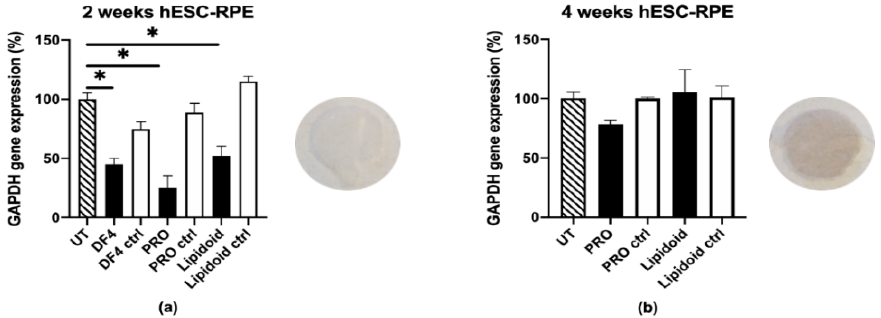
Figure 6. GAPDH mRNA knockdown in ( a ) 2-week and ( b ) 4-week matured hESC-RPE cells, 2 days after transfection. Black columns indicate the GAPDH siRNA (50 nM), the white columns indicate the negative control siRNA (50 nM). GAPDH mRNA expression was evaluated with a qPCR and normalized to the endogenous β-actin. Results are presented as the % of remaining gene expression. UT: untreated control cells; DF4: DharmaFect 4; PRO: Metafectene PRO; ctrl: negative control siRNA; * indicates statistical significance ( P < 0.05). Data are presented as mean +SD, n = 3. Cell pigmentation is visible in 4-week matured hESC-RPE.